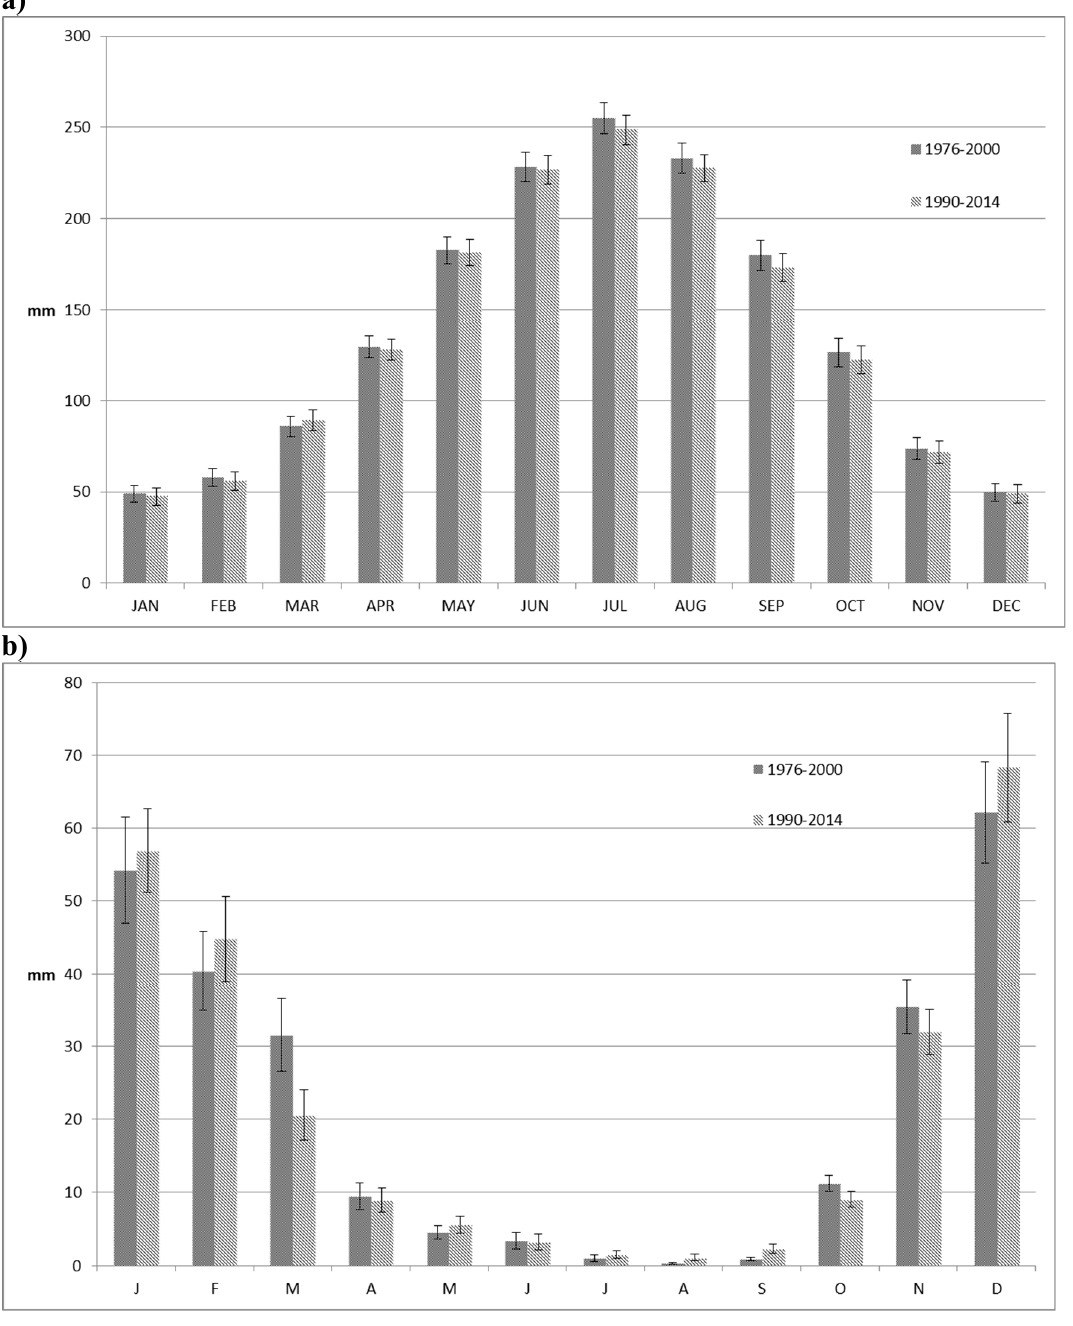
Figure 1. Monthly averages for a) Class A pan evaporation (mm) and b) effective rainfall over two 24-year periods (1976–2000 and 1990–2014) in Cyprus. Data from 16 meteorological weather stations.